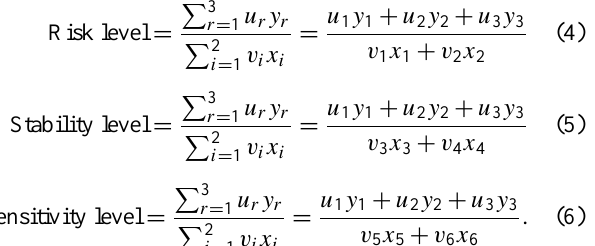
Fig.8. Spatial and temporal DMUS determination